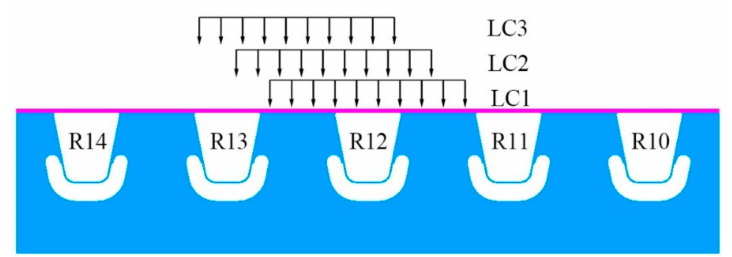
Figure 15. Three typical transverse loading locations on the panel model.